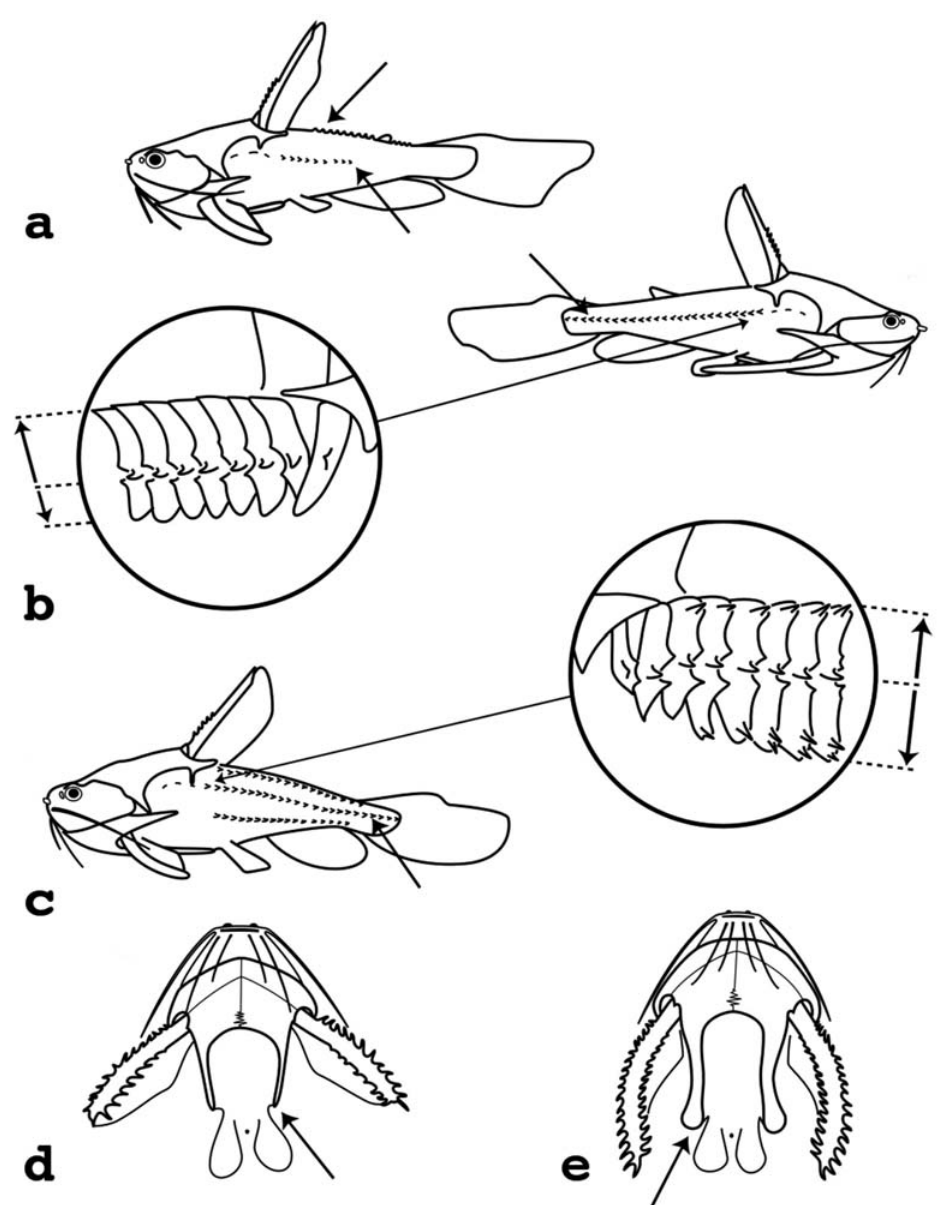
Fig. 2. Diagnostic characters of the three species of Physopyxis . a. Physopyxis cristata ; b. Physopyxis lyra ; c. Physopyxis ananas ; d. ventral view of scapular girdle in P. ananas and P. cristata ; e. ventral view of scapular girdle in P. lyra